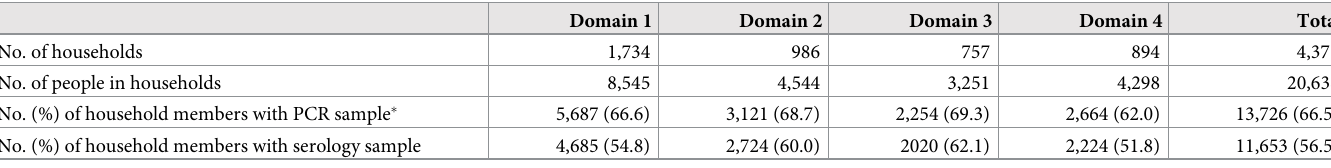
Table 1. Sample size achieved across